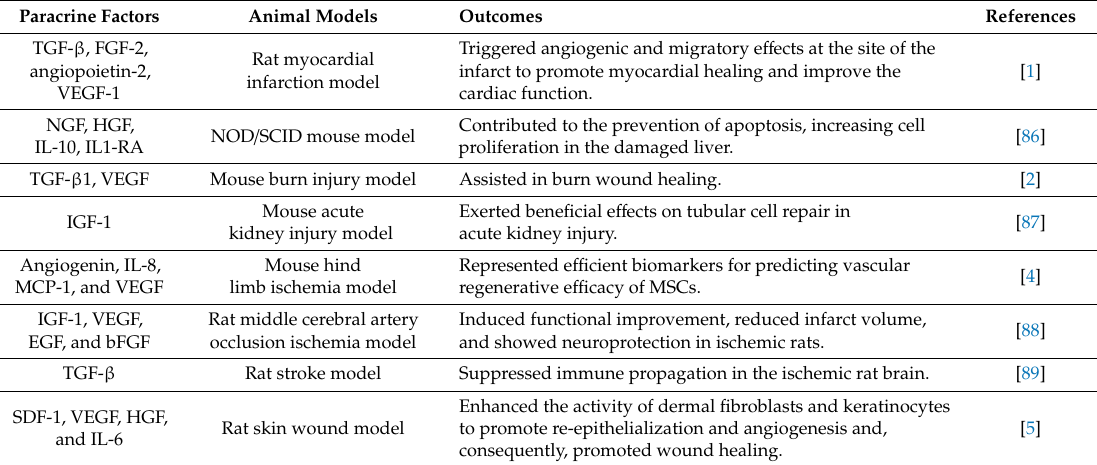
Table 3. Paracrine factors of transplanting BMSCs for tissue